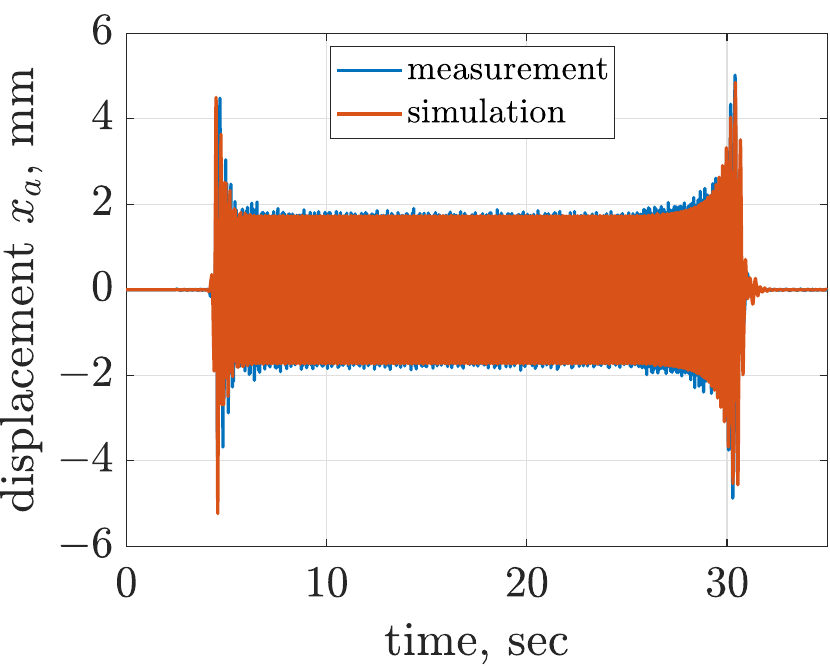
Figure 7. Comparison of time diagrams of horizontal displacement x a corresponding to the averaged sensor location evaluated for measurement and simulation results.